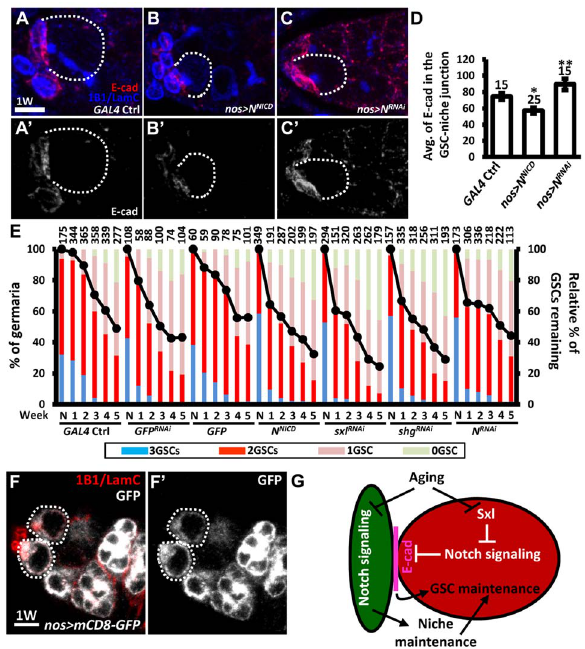
Fig. 7. Forced Notch signaling in GSCs accelerates age- dependent GSC loss. (A–C) Three-dimensional reconstructions of images from one-w-old control (A), nos-GAL4- driven N RNAi (B), and nos- GAL4- driven N NICD (C) germaria with E-cadherin (E-cad, red), 1B1 (blue, fusomes), and LamC (blue, cap cell nuclear envelopes) labels. A 9 -C 9 show the E-cadherin channel only. (D) Average (avg.) E-cadherin expression at the GSC-niche junction. The number of GSCs analyzed is shown above each bar. *, P , 0.05; **, P , 0.01. Error bar, mean 6 SEM. (E) Relative percentage of GSCs remaining in the germaria of the indicated genotypes at different ages. Flies carrying GFP or GFP RNAi driven by nos- GAL4 were used as controls. N NICD was used to increase Notch signaling; RNAi lines were used to suppress the expression of Sxl , shg , or N . The GAL4 control (ctrl) was obtained by crossing the GAL4 line with the w 1118 strain. Line graphs show the maintenance rates of GSCs with age (N, just eclosed; weeks, shown on the x axis). GSC maintenance rates for each genotype were determined by normalizing the average numbers of GSCs at each time point to that in newly eclosed flies. The maintenance rates of both N NICD -overexpressing and Sxl RNAi -knock down GSCs were significantly different from those of all the controls ( P , 0.05), as determined by Wilcoxon Signed-Rank test. Bar graphs indicate the distribution of germaria with 0, 1, 2, or 3 or more GSCs at the indicated weeks. The number of germaria analyzed is shown above each bar. (F) One-w-old nos-GAL4- driven UASp-mCD8-GFP germaria with GFP (gray), 1B1 (red, fusomes), and LamC (red, cap cell nuclear envelopes) labels. F 9 shows the GFP channel only. Scale bars in A and F are 5 m m. (G) Notch signaling mediates coordination between GSCs and their niche in response to aging. Aging reduces Notch signaling activity in cap cells, which disrupts niche integrity, and thus affects GSC maintenance; on the other hand, aging up-regulates Notch signaling at the GSC-niche junction (at least in part through Sxl), thereby promoting GSC loss via the suppression of E-cadherin expression. Dark green, cap cell; red,